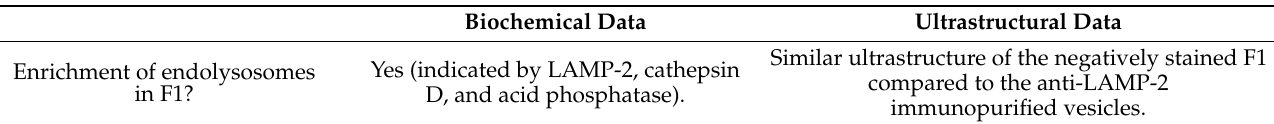
Table 1. Summary of the main outcome of the biochemical and ultrastructural characterization of the improved endolysosomal enrichment method. Data were compiled for fraction 1 (F1) of the subcellular fractionation procedure. For details see